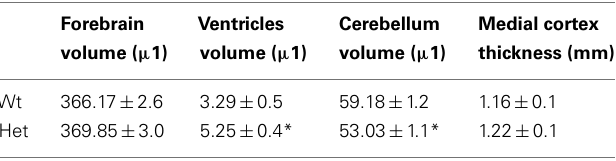
Table 2 |Analysis for forebrain, cerebellum, and ventricles volume